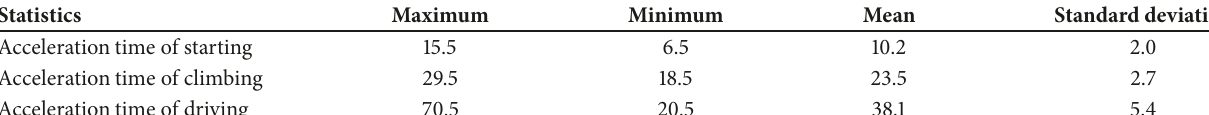
Table 2: Acceleration time statistics of the three indices (units: s).